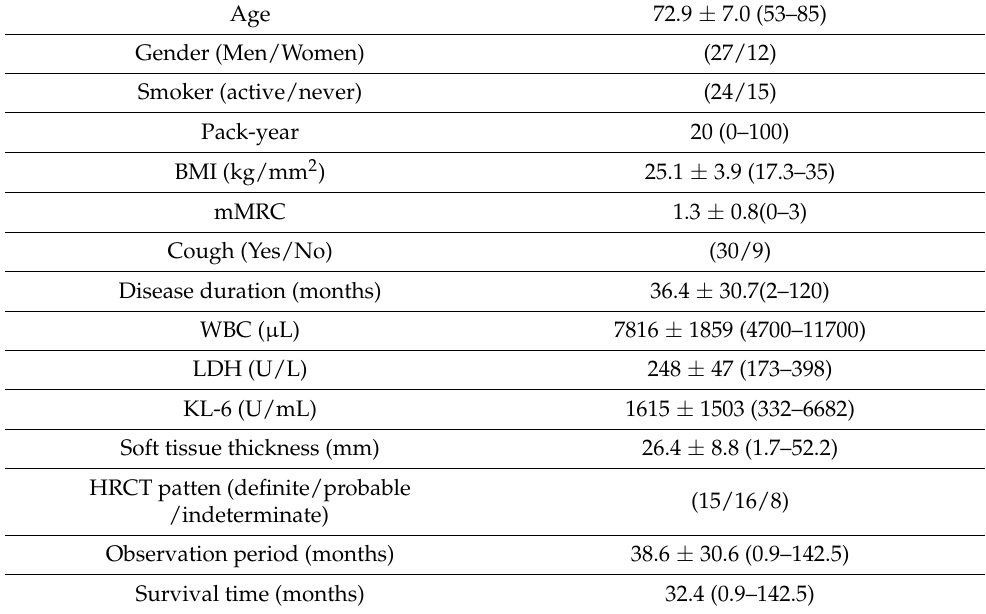
Table 1. Clinical characteristics of IPF patients receiving anti-fibrotic agent ( n =